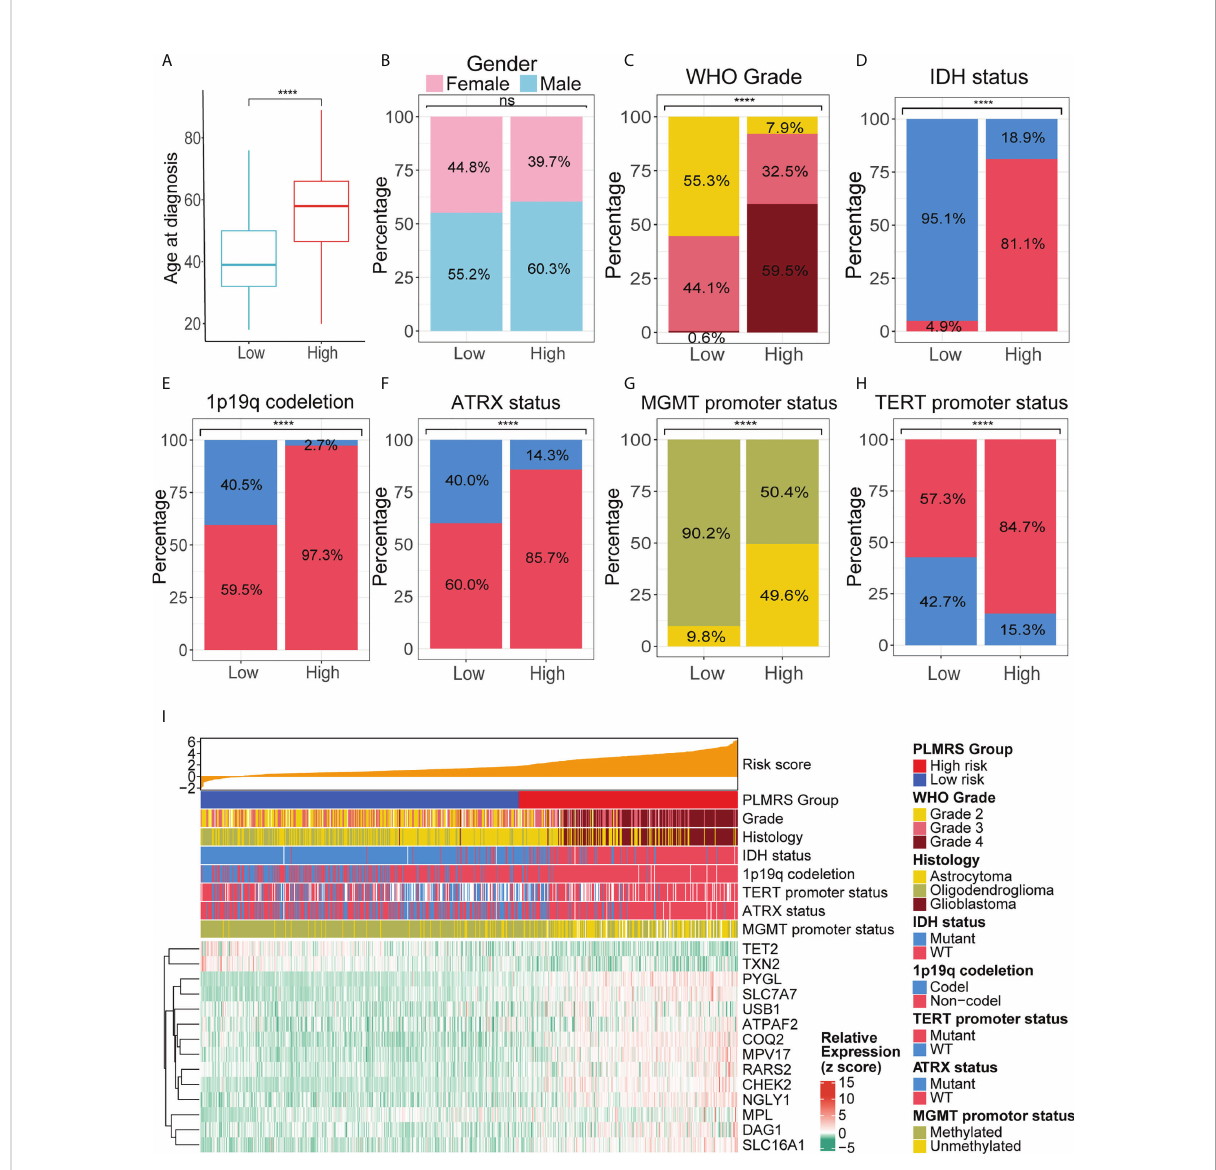
FIGURE 9 Comparison of clinicopathological characteristics in two PLMRS risk groups. Differences between the high and low risk groups were compared in age at diagnosis (A) , gender (B) , tumor grade (C) , IDH mutations (D) , 1p19q codeletion (E) , ATRX mutation (F) , MGMT promoter methylation (G) , TERT promoter mutation (H) . (I) Heatmap summarizing the clinicopathological feature and expressing PRLMGs in two risk groups. PLMRS, prognostic lactate metabolism risk score; TCGA, The Cancer Genome Atlas; WHO, World Health Organization; IDH, isocitrate